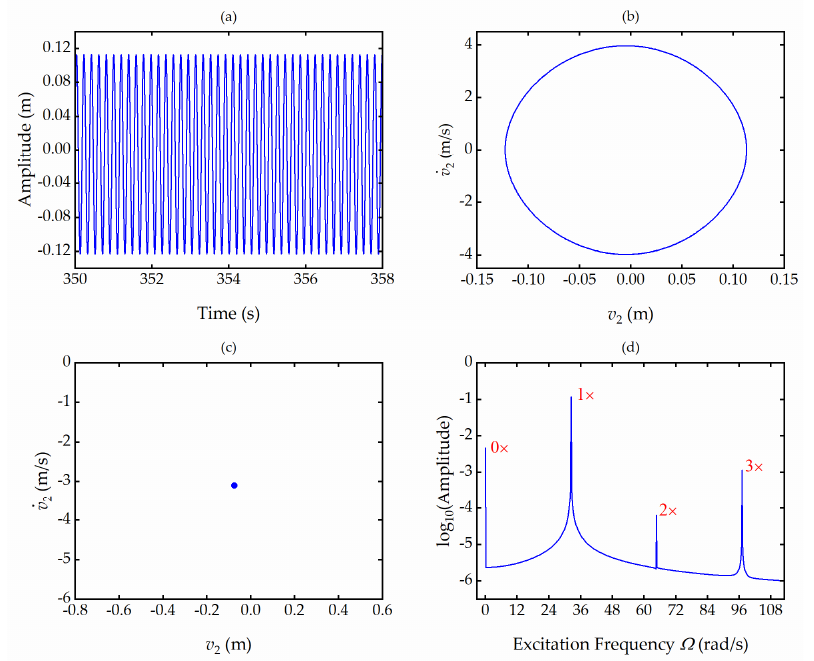
Figure 11. Response of a system with only second − order nonlinear terms for the case of w 0 = 0.0008 m, Ω = 32.34 rad/s: ( a ) Time history of steady state. ( b ) Phase portrait. ( c ) Poincare map. ( d ) Spectrum response.